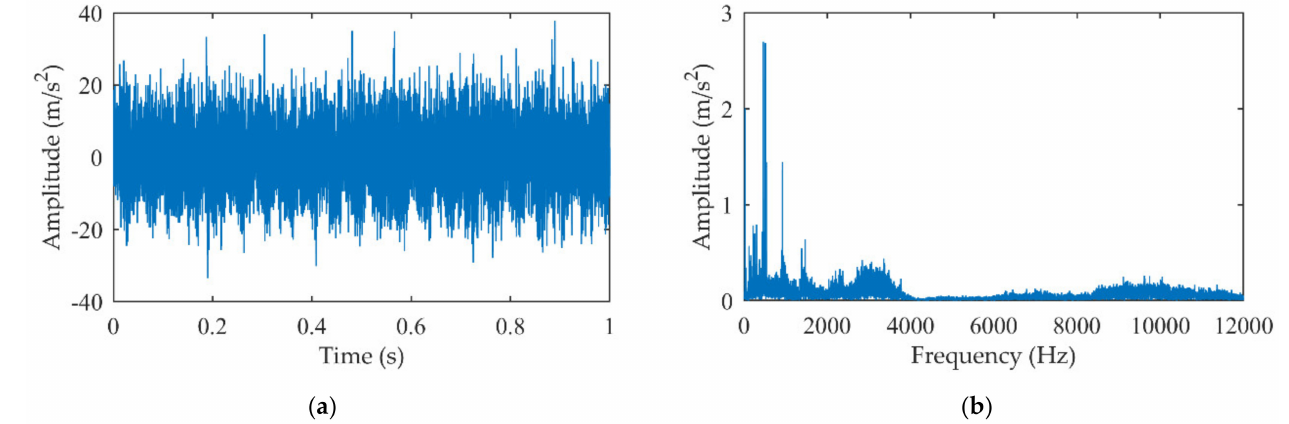
Figure 14. The measured acceleration signal of the five-speed transmission experiment: ( a ) Time domain signal; ( b ) Amplitude spectrum.